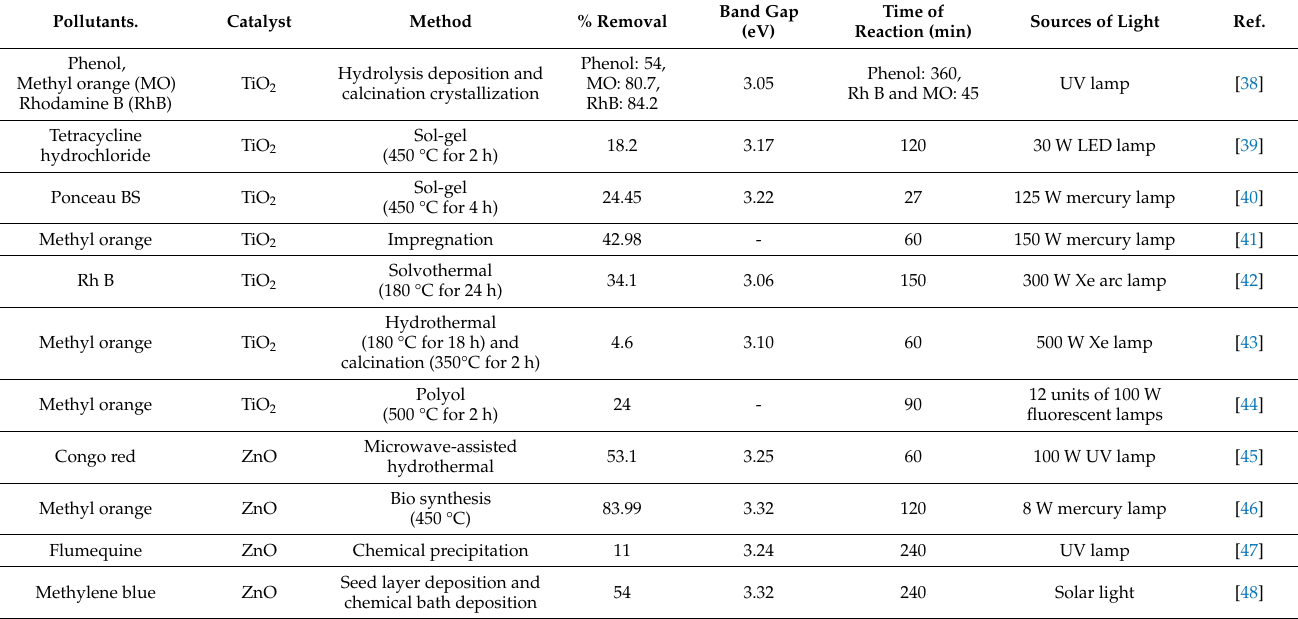
Table 1. List of metal oxides nanomaterials as photocatalyst and its efficiency towards various pollutants in wastewater.